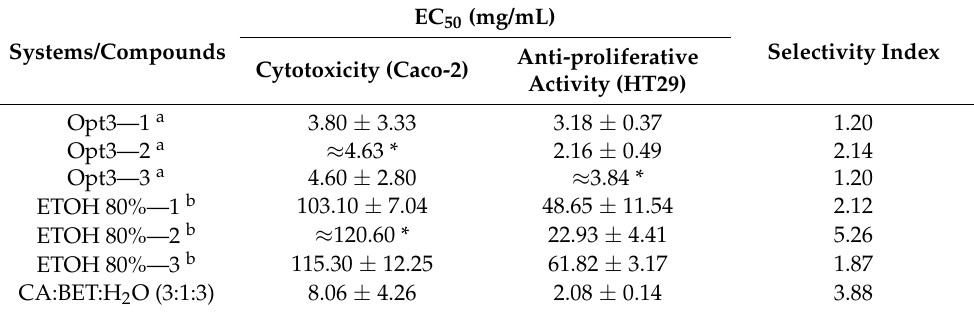
Table 6. Anti-proliferative activity (HT29), cytotoxicity (Caco-2), and selectivity index of optimal